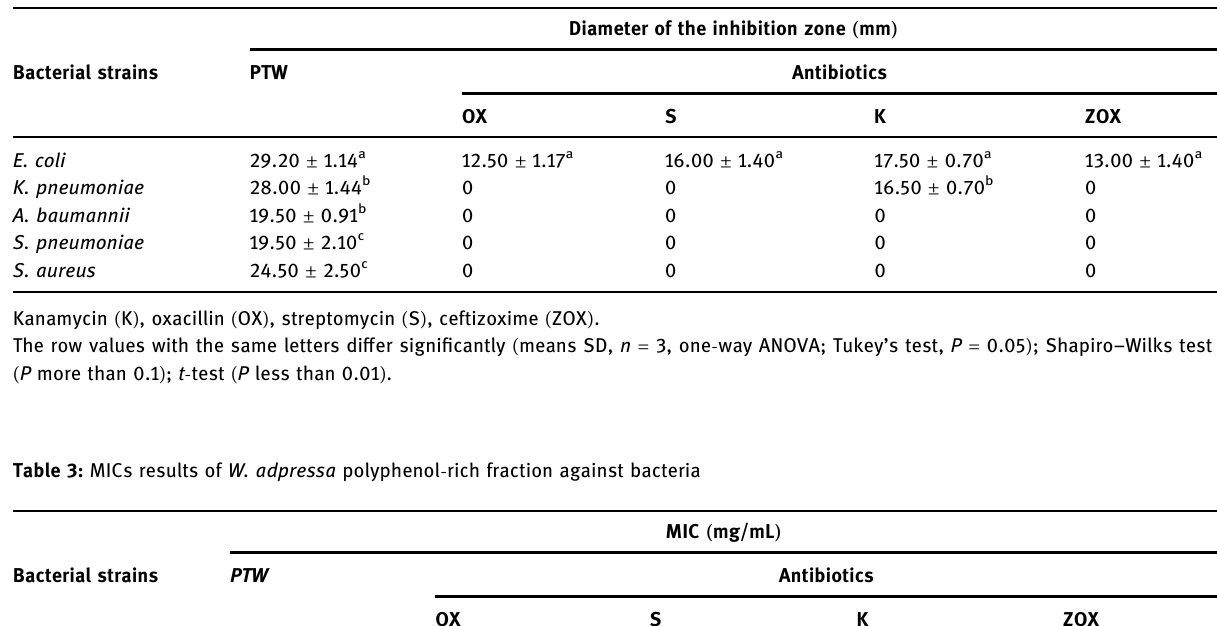
Table 2: Inhibition results of W. adpressa polyphenol - rich fraction against bacteria Bacterial strains